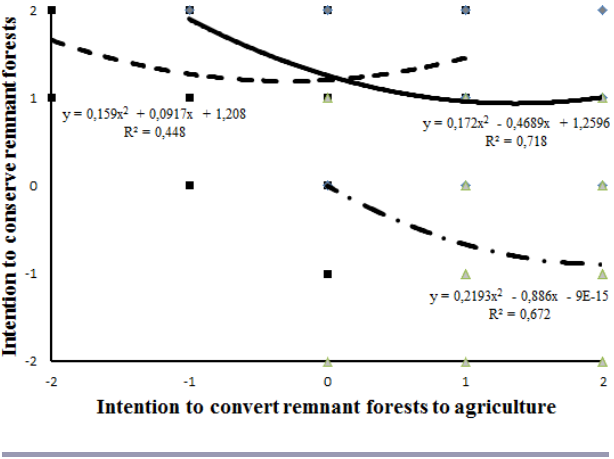
Fig. 2 . Indifference curves of preproductivist (- - -), multifunctional (----), and productivist (-.-.-) landholder groups, built upon combinations of intentions to conserve and convert forest remnants in their landholdings (indicated by black squares for preproductivist, dark grey diamonds for multifunctional, and light grey triangles for productivist